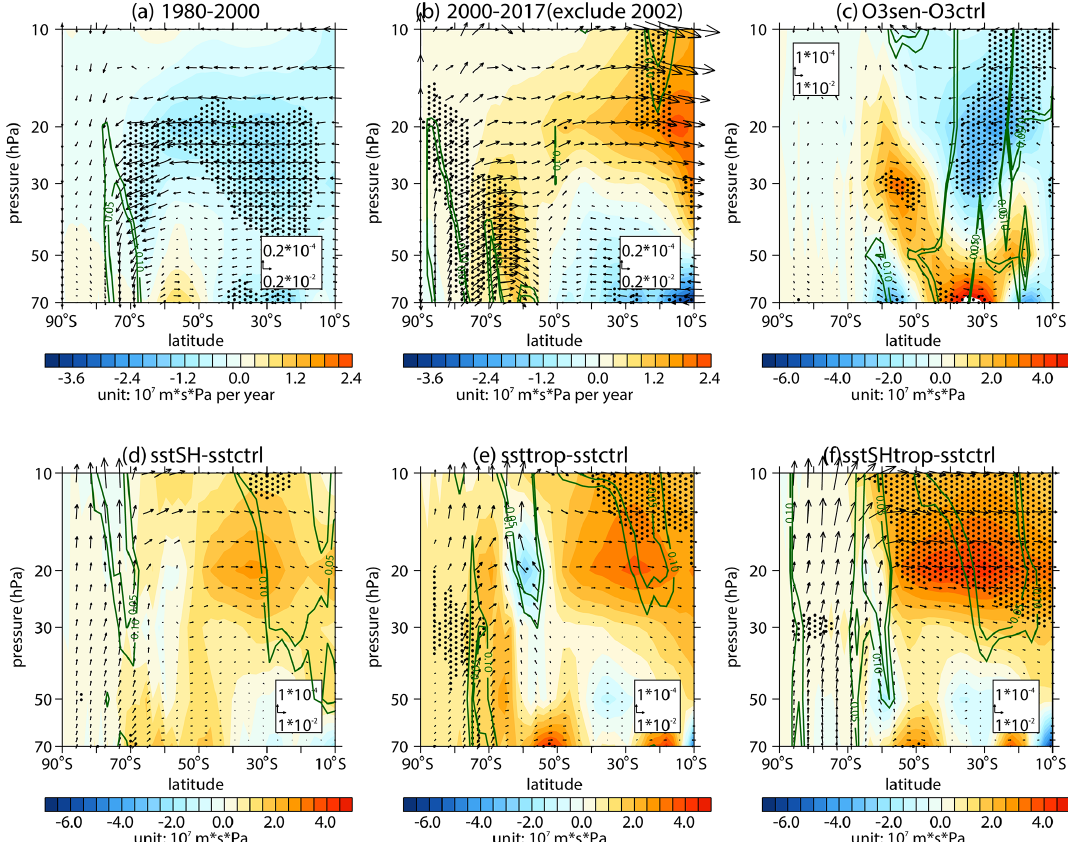
Figure 15. (a) Trends of the southern hemispheric Brewer–Dobson circulation (arrows; units in horizontal and vertical components are 0.2 × 10 − 2 and 0.2 × 10 − 4 ms − 1 yr − 1 , respectively) and its stream function (shading) in September during (a) 1980–2000 and (b) 2000– 2017 as derived from the MERRA-2 dataset. Data in 2002 are removed when trends are calculated in panel (b) . (c) Differences in the Brewer–Dobson circulation (arrows; units in horizontal and vertical components are 10 − 2 and 10 − 4 ms − 1 , respectively) and its stream function (shading) between the O3ctrl and O3sen. (d, e, f) Differences in the Brewer–Dobson circulation and its stream function between the control experiment (sstctrl) and sensitivity experiments ( d sstSH; e ssttrop; f sstSHtrop) with SST changes. The stippled regions represent the trends or differences in the stream function significant at/above the 90% confidence level. The green contours from outside to inside (corresponding to p = 0.1 and 0.05) represent the trends or differences in the vertical components significant at the 90% and 95% confidence levels,